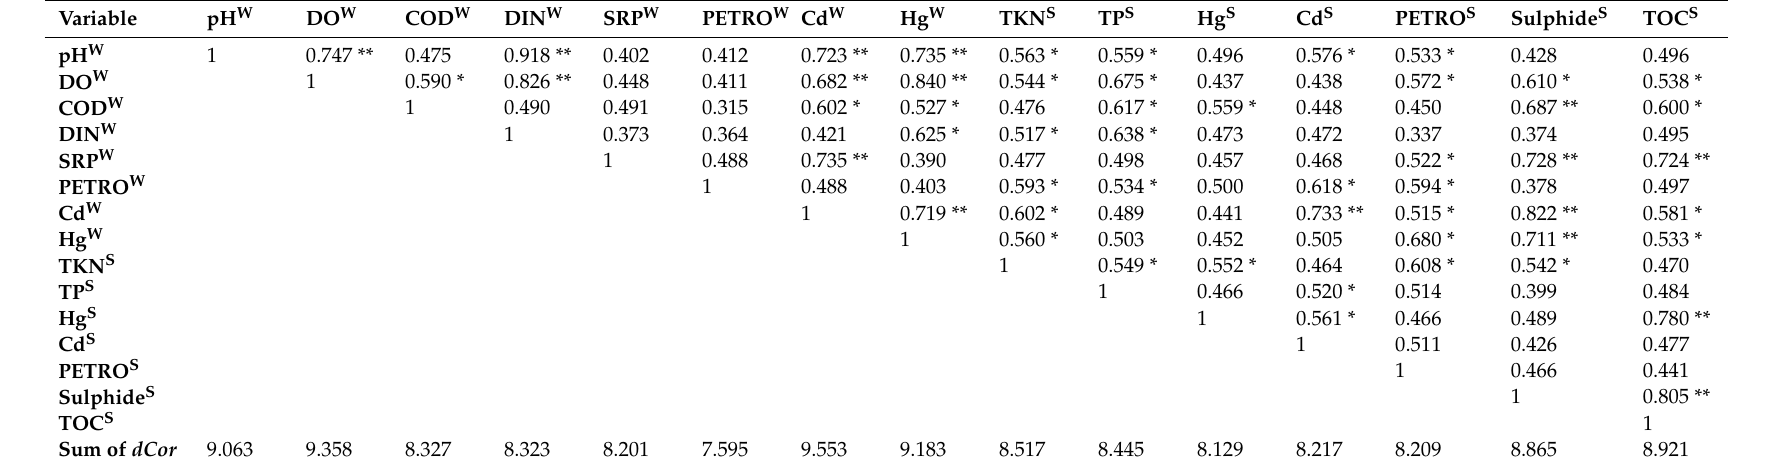
Figure 7. The box charts of ( a ) pollution status; ( b ) temporal variation; and, ( c ) spatial variation of the variable measurements. Table 3. Distance correlations ( dCor ) among the measured variables across the reclamation area.